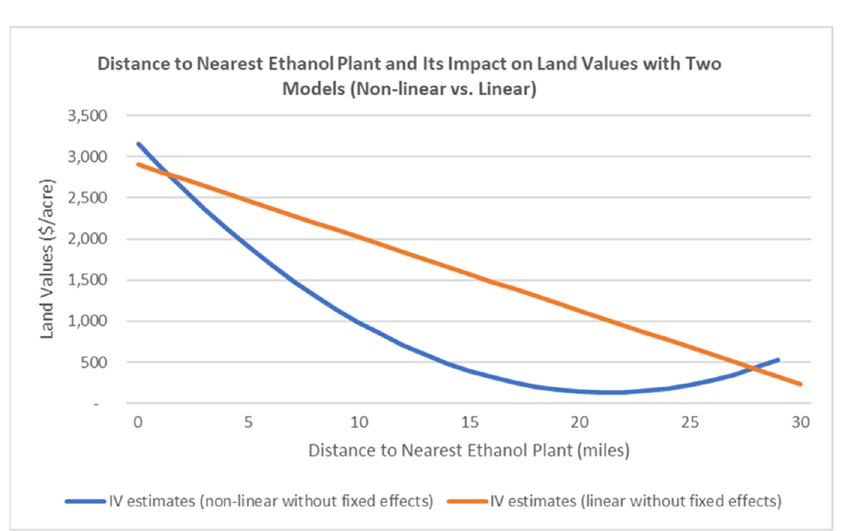
Figure 2. Distance to nearest ethanol plant and land values: comparison of linear and non-linear models.